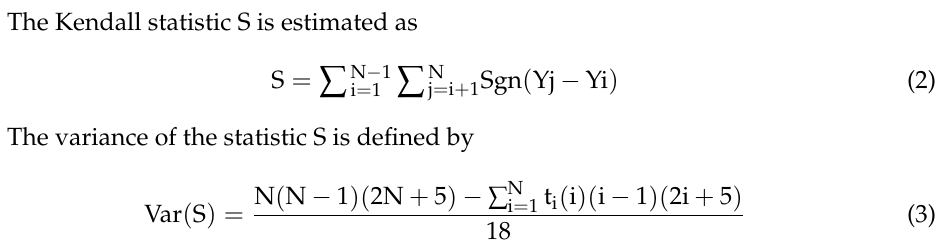
Figure 5. Methodology for climatic variation